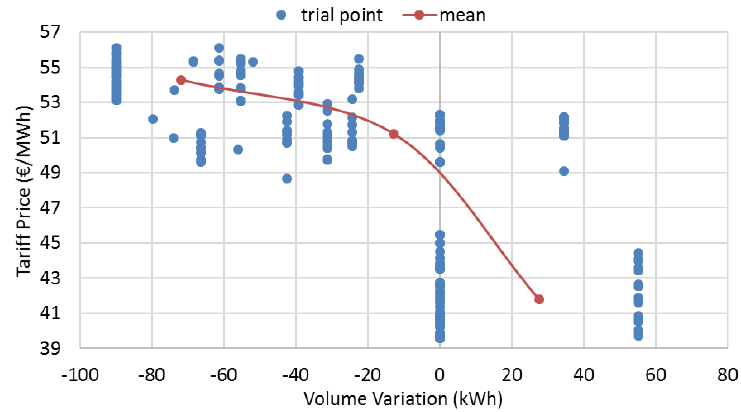
Figure 2. Consumer response to a three-rate